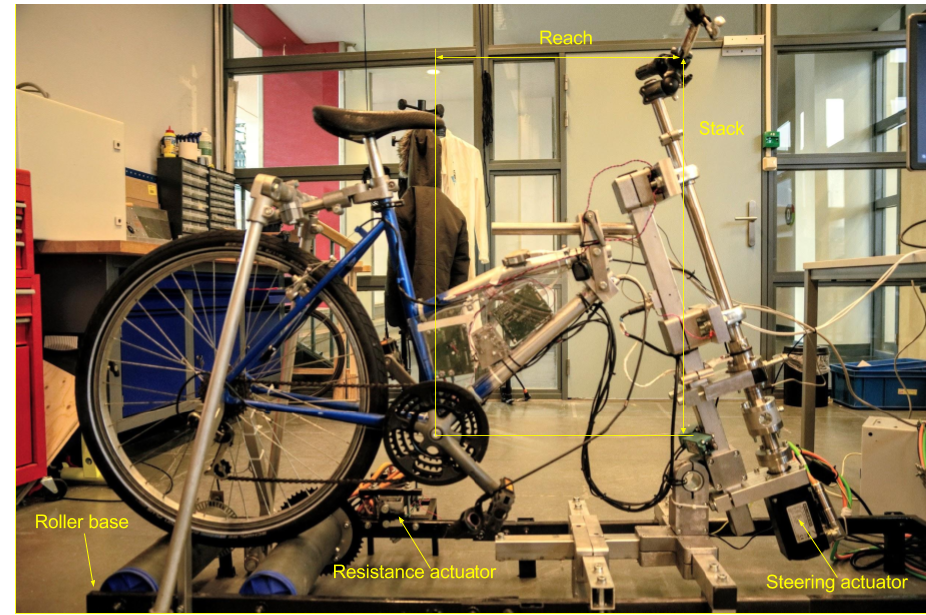
Figure 2. TU Delft fixed base bicycle